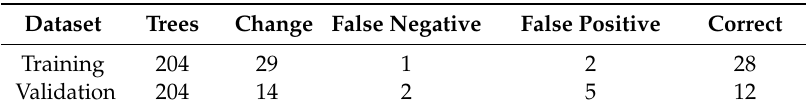
Table 3. Explanation of calculated values for training and validation datasets. Trees—total number of trees in dataset; change—number of trees with branch bending detected; false negative—trees with branch bending but not detected; false positive—incorrectly detected as trees with branch bending; correct—correctly detected as trees with branch